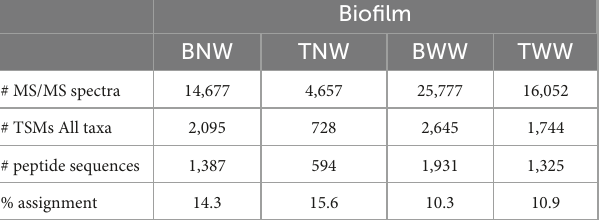
TABLE 1 Data (or characteristics) of the MS/MS spectra acquired per LC-MS/MS run and their interpretation, for each